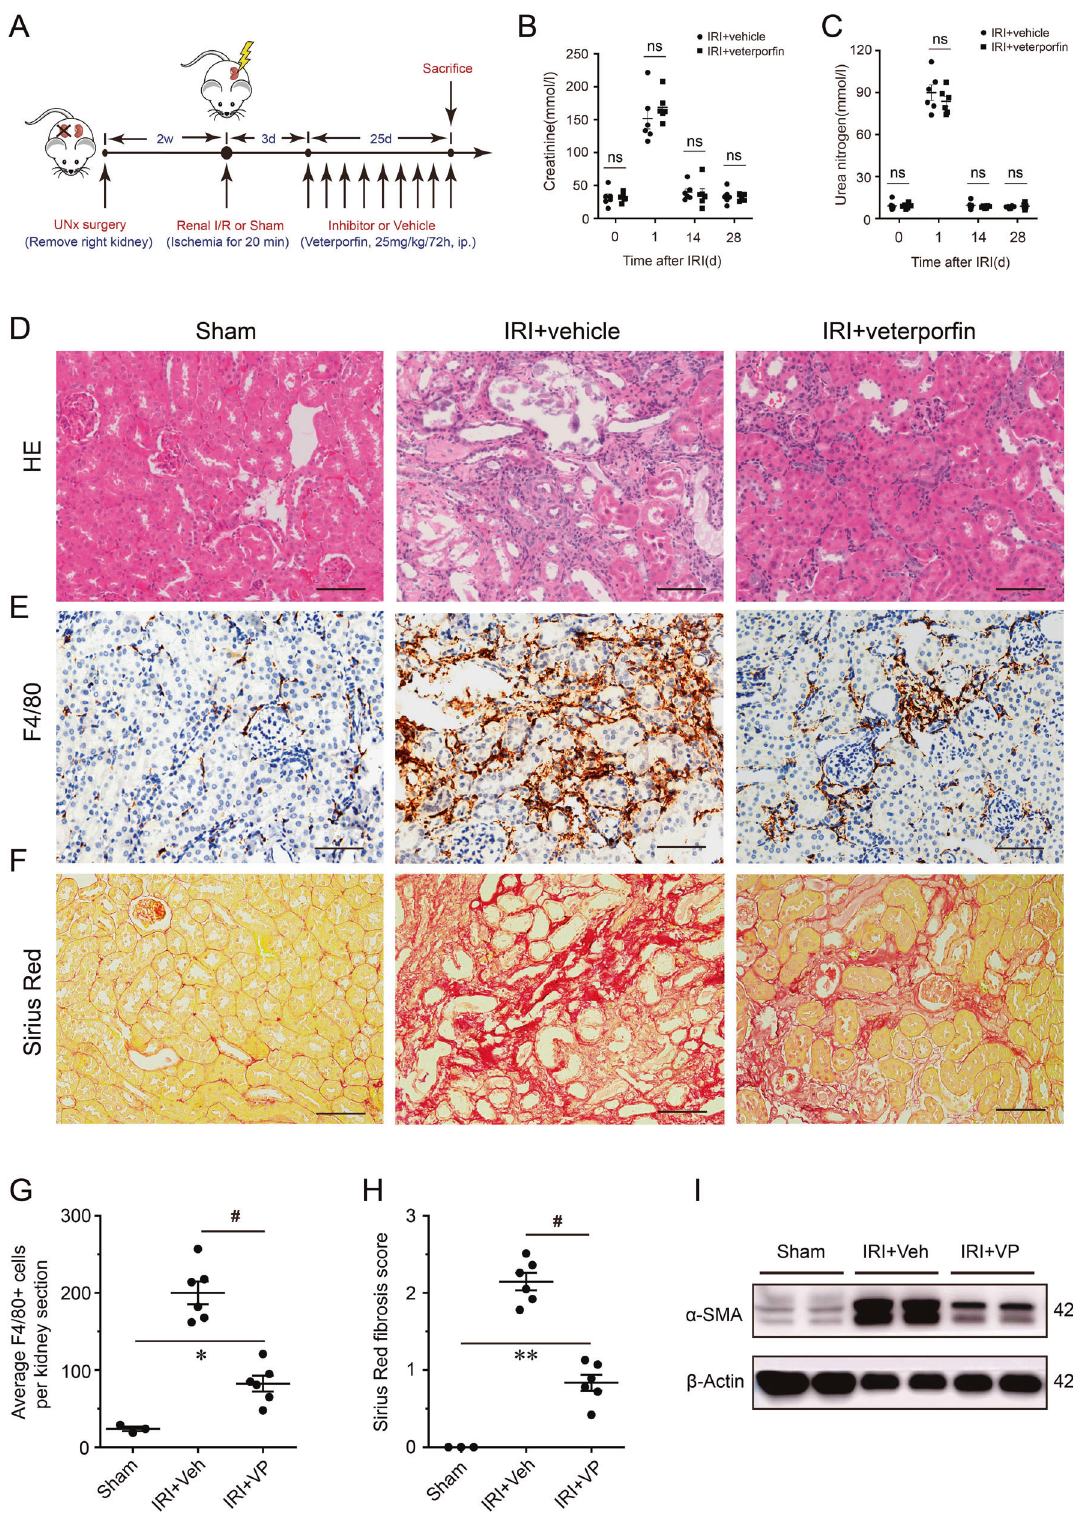
Fig. 4 The impact of pharmacological inhibition of YAP on renal in fl ammatory in fi ltration and fi brosis after AKI. A Experimental design of YAP inhibition in ischemic AKI mice using vertepor fi n (25 mg/kg/72 h, i.p.). B The effect of vertepor fi n on serum creatinine and C urea nitrogen followed IRI ( n = 6 mice). D Representative images of renal cortex stained with HE. E Representative images of immunohistochemistry staining for F4/80 in vertepor fi n treated mice and vehicle groups with AKI. F Representative images of renal Sirius Red staining. G Quanti fi cation of F4/ 80-positive cells in kidney ( n = 3 for sham and n = 6, 6 for IRI + Veh and IRI + VP, respectively). H Semi-quanti fi cation of Sirius Red staining ( n = 3 for sham and n = 6, 6 for IRI + Veh and IRI + VP, respectively). I Renal expression of α -SMA in Sham, IRI + Veh, and IRI + VP mice. Shown are representative blots from at least three separate experiments with similar results. Scale bar = 50 µm in all images of D , E , and F . All values are means ± SEM. * p < 0.05, ** p < 0.01, and # p < 0.001 de fi ned as signi fi cant. ns not signi fi cant. Cell Death and Disease (2021)